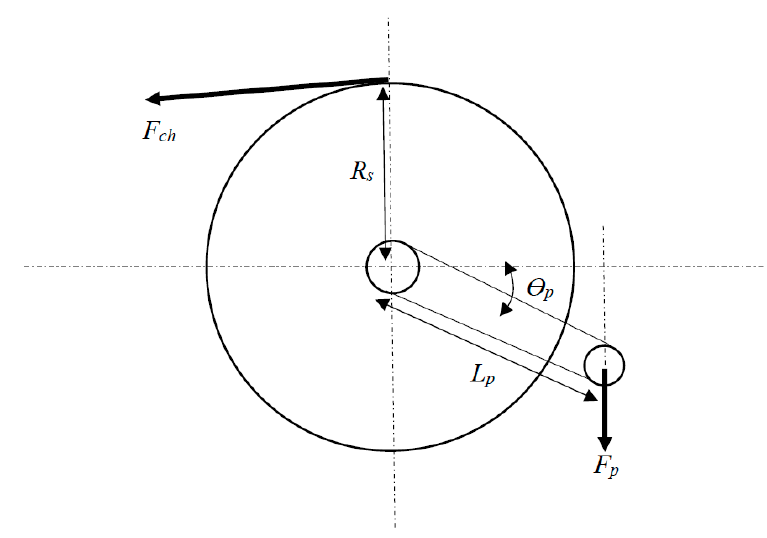
Figure 4. Cycling dynamics.